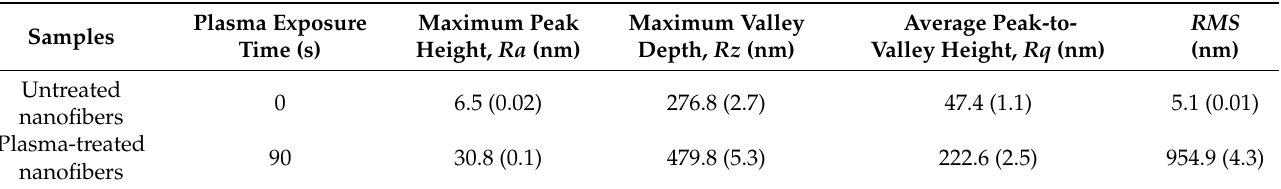
Figure 1. ( A ) SEM image of untreated gelatin nanofibers, ( B ) SEM image of atmospheric-air plasma-treated gelatin nanofibers, ( C ) AFM image of untreated gelatin nanofibers, ( D ) AFM image of atmospheric-air plasma-treated gelatin nanofibers. Table 1. Different parameters extracted from AFM analysis for the untreated and atmospheric-air plasma-treated gelatin nanofibers (standard deviations in parenthesis).